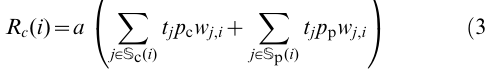
during one tRNA insertion attempt. (B) Parameter